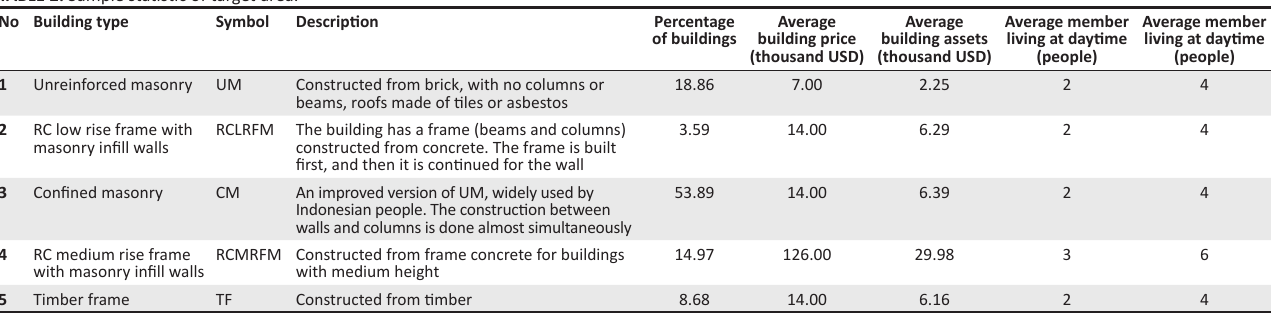
FIGURE 4: (a) Sample of confined masonry, (b) sample of reinforced concrete medium rice frame with masonry infill walls and (c) timber TABLE 2: Sample statistic of target area.